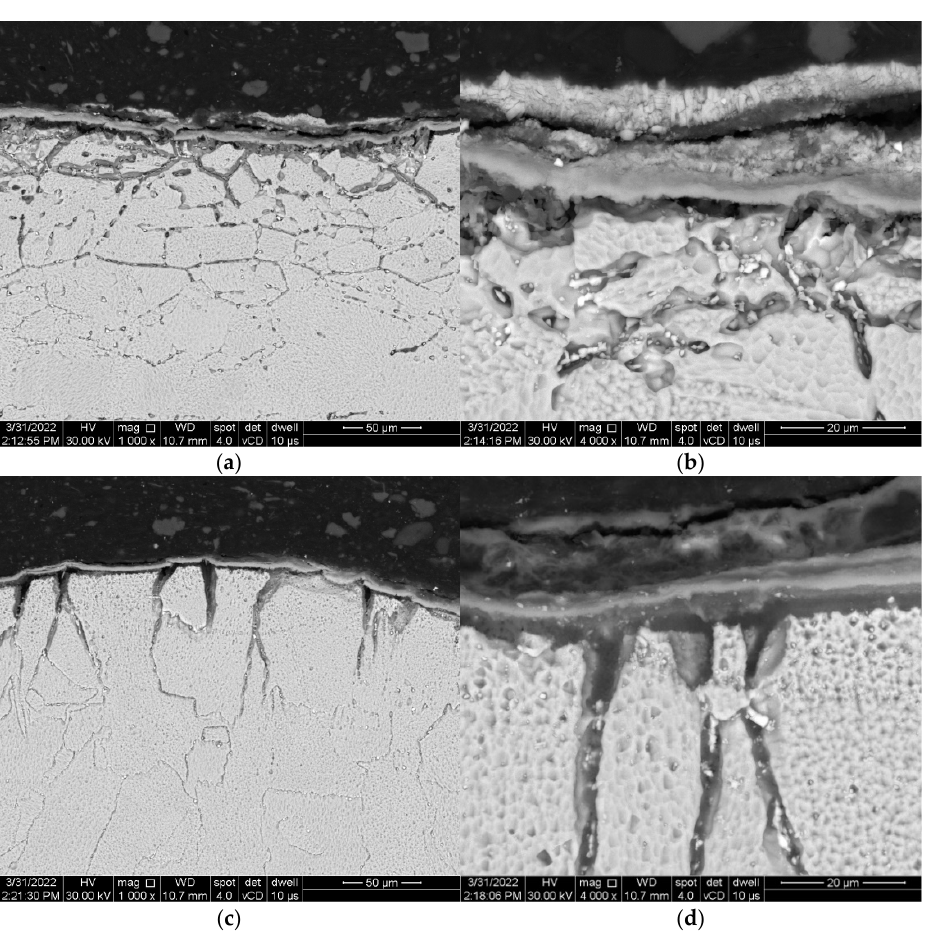
Figure 8. SEM images with micro-cracks formed at grain boundaries in AP ( a , b ) and 3DPP ( c , d ) at 1000 °C/8 h, revealed by etching with aqua regia.